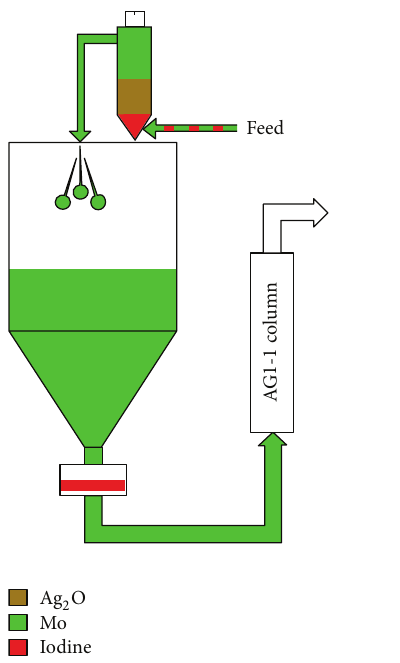
Figure 4: Separation of iodine on the floating silver oxide column.